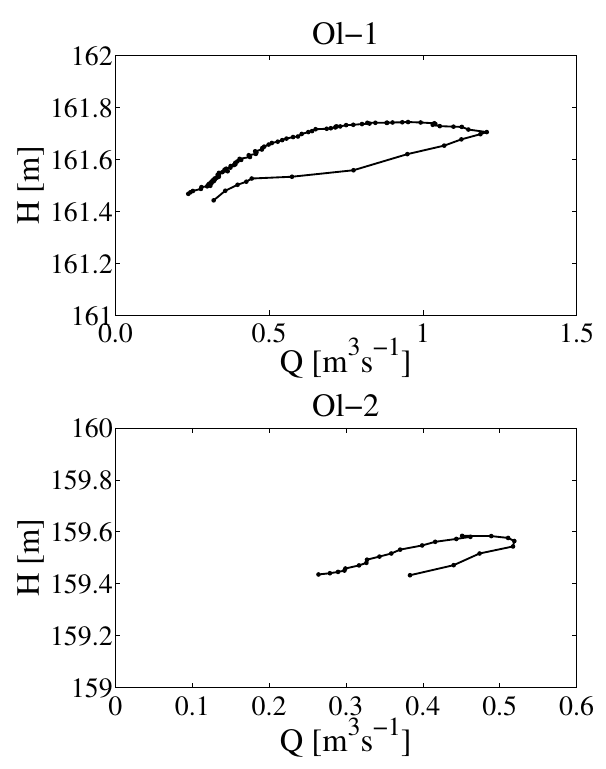
Figure 5. Rating curves of experimental flood waves in the Ol- szanka